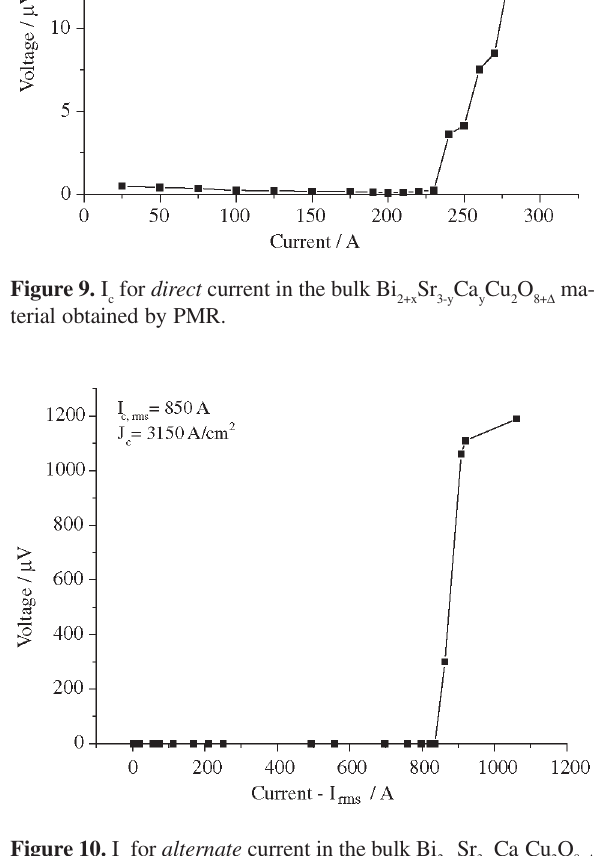
for alternate current in the bulk Bi c